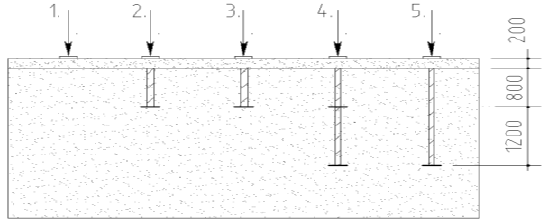
Figure 11. Scheme of the tested samples. 1 — reference soil, µ = 0; 2 — steel screw-type reinforcing element, diameter: 100 mm, µ = 0.23; 3 — FRP element, diameter: 100 mm, µ = 0.27; 4 — FRP element with two screws, diameter: 75 mm, µ = 0.51; 5 — FRP element with single screw, diameter: 75 mm, µ = 0.33.